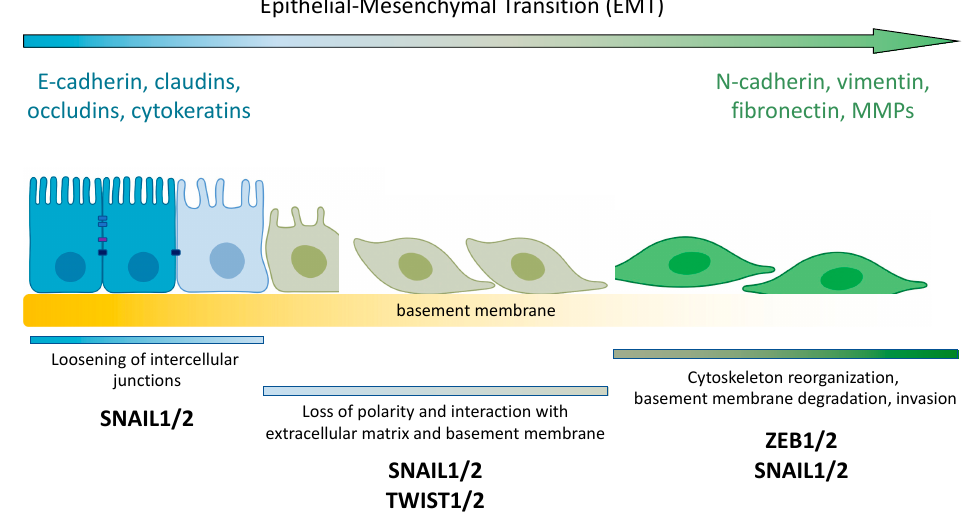
Figure 3. Schematic diagram of the epithelial–mesenchymal transition (EMT) and EMT transcription factors. There are a limited number of critical transcription factors that activate EMT. This core set of EMT master regulators includes zinc-finger E-box-binding homeobox 1 (ZEB1) and ZEB2, Snail (SNAI1), Slug (SNAI2), and Twist-related protein 1 (TWIST1). The EMT is a process by which epithelial cells lose their apicobasal polarity and intercellular contacts and transform into mesenchymal cells, acquiring the ability to migrate. The process of EMT causes suppressed expression of epithelial markers (such as E-cadherin) and upregulation of mesenchymal markers (such as N-cadherin). As a result, cells acquire motility and invasive properties.